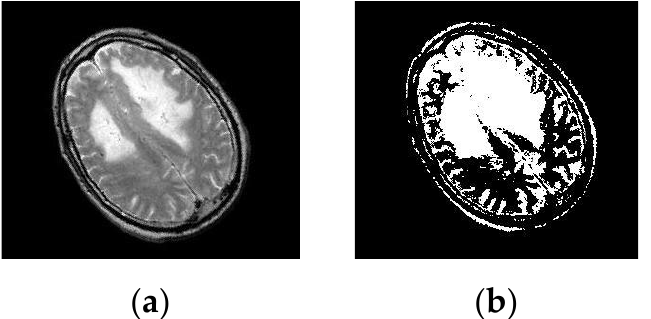
Figure 4. Here, image ( a ) is the input T-1 brain MRI image and image ( b ) is the segmented T-1 image. A segmented image classifies it as a Benign Tumor.